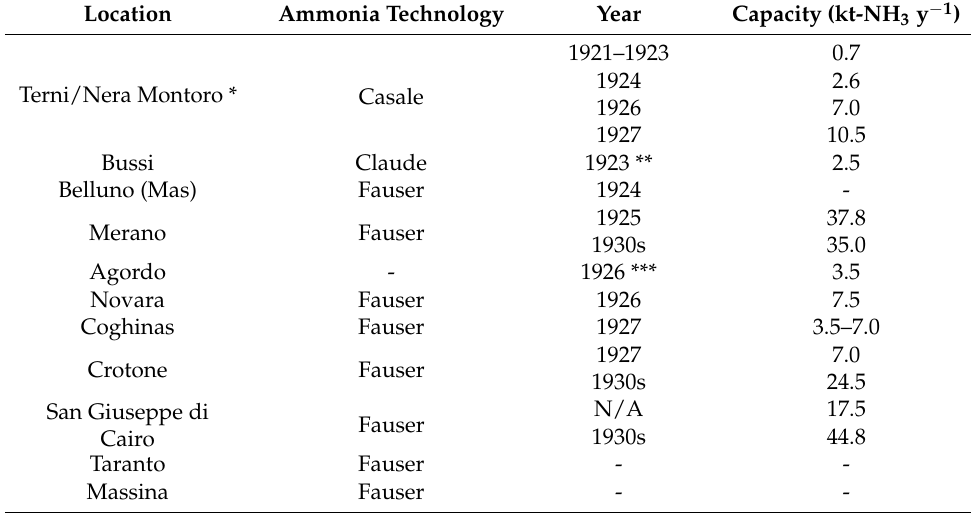
Table 2. Renewable ammonia plants in Italy. Values adapted from references [12,22,29].